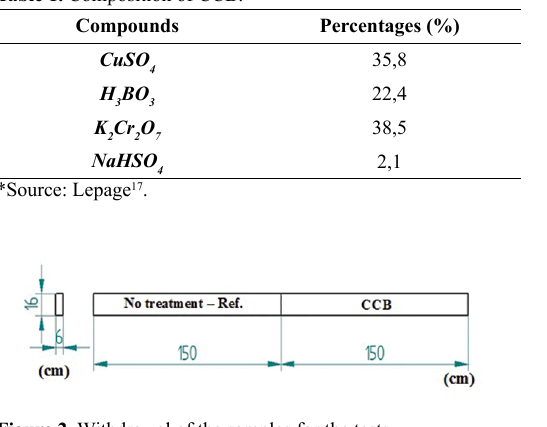
Figure 2. Withdrawal of the samples for the tests.